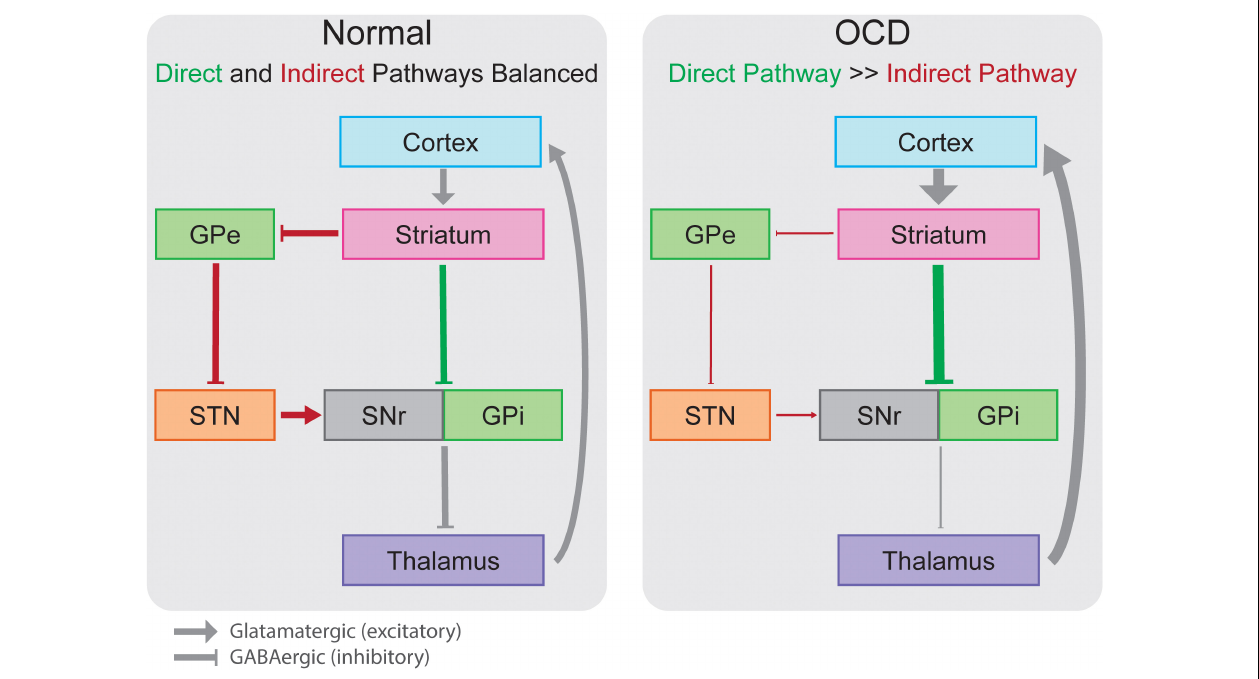
FIGURE 2 | In the normally functioning cortico-striato-thalamo-cortical circuit, direct (green) and indirect (red) pathways lead to increased or decreased inhibition of the thalamus, respectively, in a balanced manner. In OCD, overactivation of the direct pathway out of proportion to the indirect pathway leads pathologic overactivity of cortical regions in an insidious excitatory loop. Boxes colored as in Figure 1 representing anatomic regions. GPe, globus pallidus externa; GPi, globus pallidus interna; SNr, substantia nigra pars reticulata; STN, subthalamic